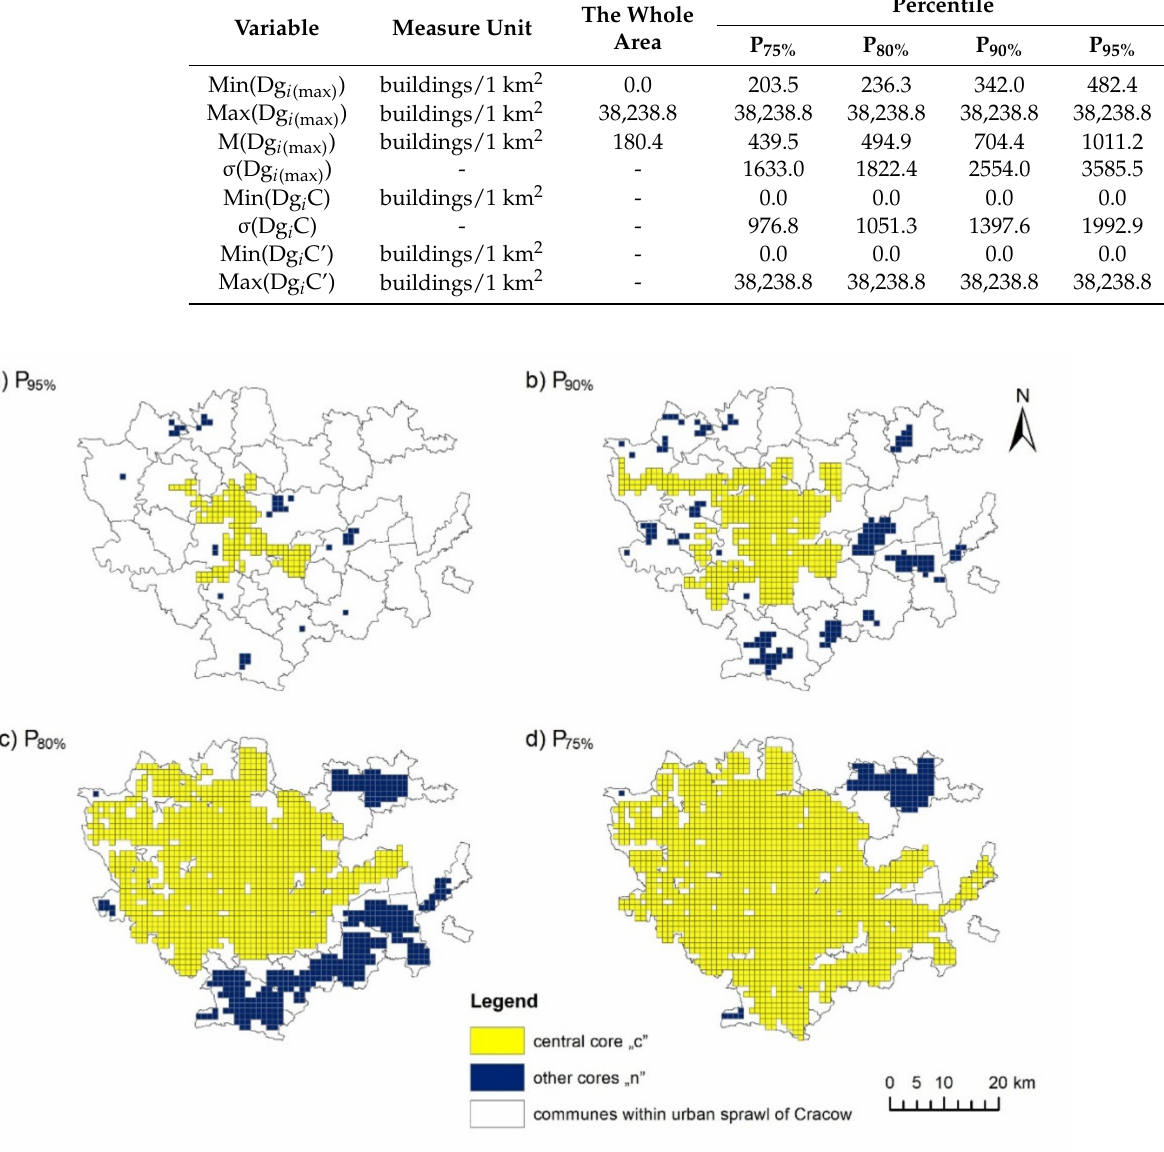
Figure 4. Nuclearity in the Cracow area excluding extreme building densities: ( a ) P 95% , ( b ) P 90% , ( c ) P 80% , ( d ) P 75% . The graphic illustration of the results forces the consideration of only two